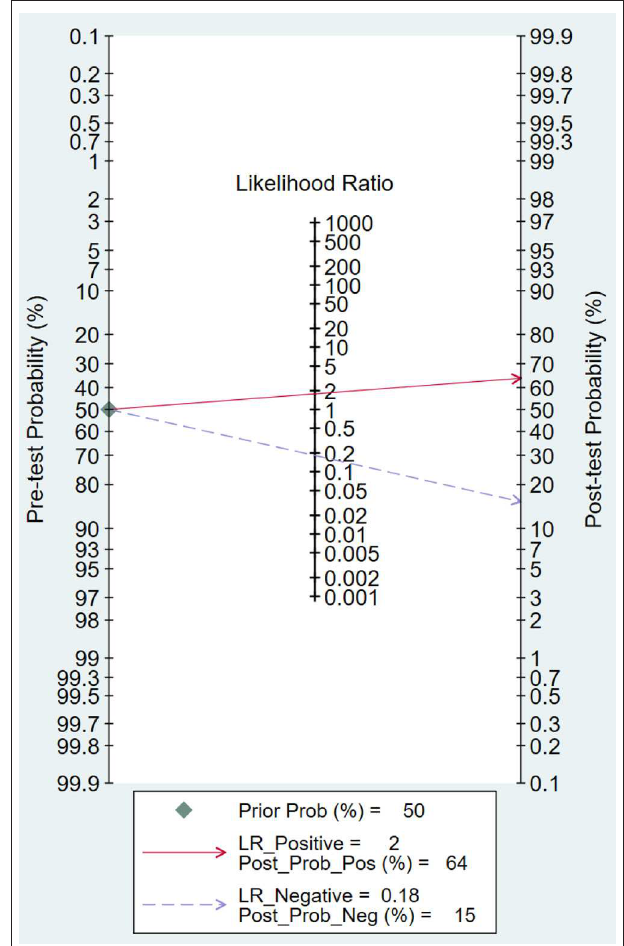
FIGURE 7 | Fagan plots of micro-ultrasound by patient analysis for the diagnosis of prostate